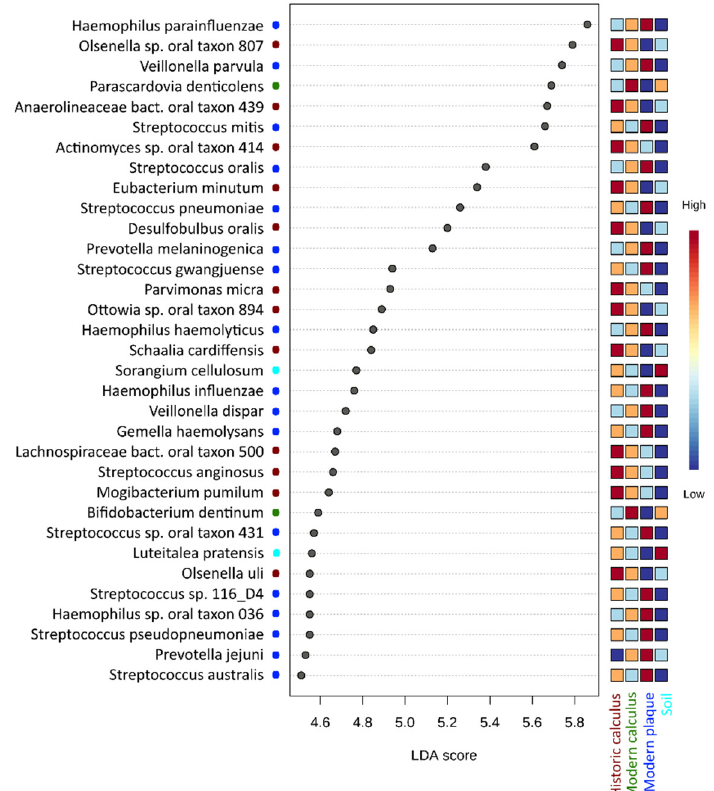
Figure 3. Linear discriminant analysis (LDA) combined with effect size measurements (LEfSe) identified species that enabled discrimination between the microbiotas of ancient calculus, modern calculus, modern plaque and burial soil samples. False Discovery Rate (FDR)-adjusted p value cutoff: 0.05; logarithmic LDA score ≥ 4.5.